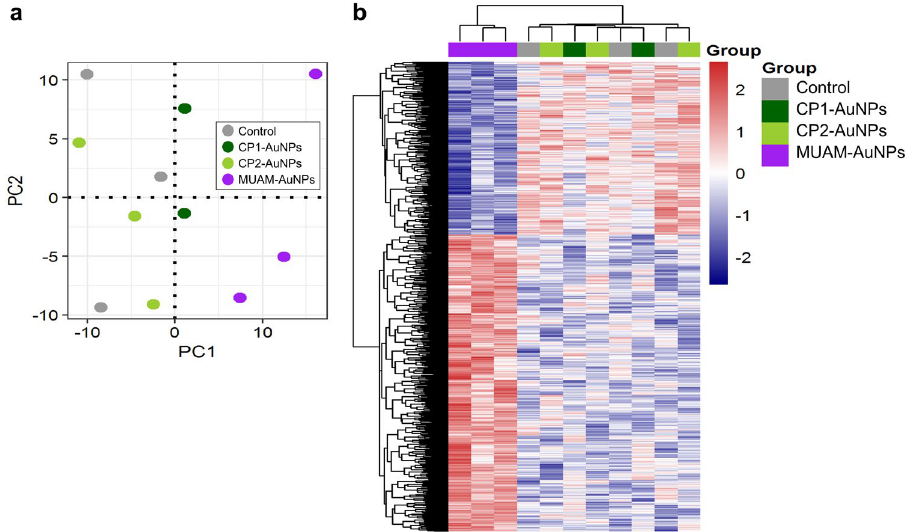
Figure 6. Gene expression profiles of HeLa cells treated with cationic gold nanoparticles (AuNPs) ( a ) Global gene expression profiles of the cationic AuNPs (MUAM-, CP1-, and CP2-AuNPs) treated cells were analysed by principal component analysis. The MUAM-AuNPs treated cells showed unique gene expression patterns, while the CP1- and CP2-AuNPs treated samples showed the patterns similar to the control. ( b ) Heat map analysis of gene expression pattern shows hierarchical clustering of 1,156 differentially expressed genes between MUAM- AuNPs treated samples and the group of three other samples. Red and blue colours indicate up- and down- expression levels,